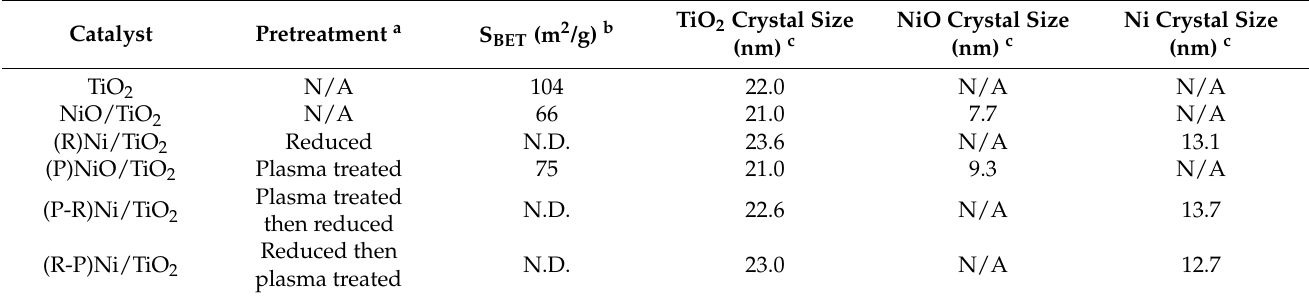
Table 1. BET specific surface area and crystallite size (TiO 2 , NiO, and Ni) of as-prepared and pretreated Ni/TiO 2